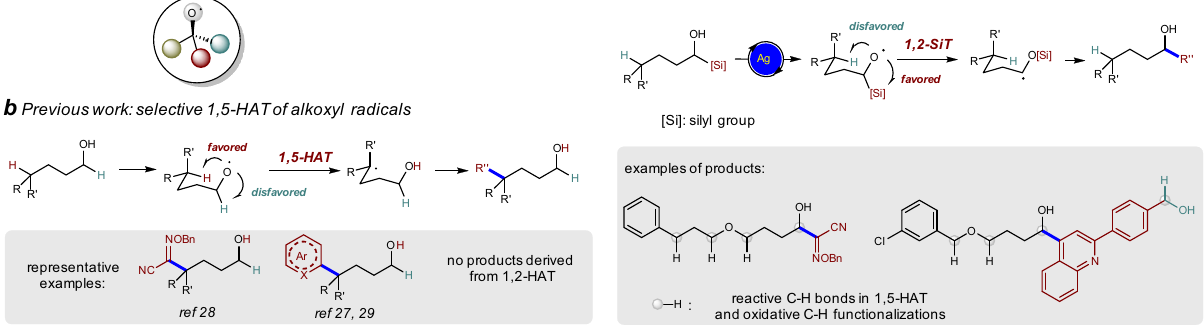
Fig. 1 Tuning the reactivity of alkoxyl radicals from 1,5-HAT to 1,2-SiT by the incorporation of a silyl group. a Alkoxyl radicals are important synthetic intermediates. b Intramolecular 1,5-hydrogen atom transfer (HAT) via a six-membered ring transition state is usually favored over the transfer of hydrogen atoms at other positions, thus alkoxyl radicals mediated δ -C – H functionalization is widely studied. c We disclose here that 1,2-silyl transfer (SiT) is favored over 1,5-HAT under Ag-catalyzed conditions, allowing the ef fi cient synthesis of α -hydroxyl oxime ethers and α -heteroaryl alcohols (this work). The alkoxyl radical-mediated reactions can tolerate many reactive C – H bonds, which are reactive in 1,5-HAT and oxidative C – H functionalizations. Another OH group in the substrates can also be